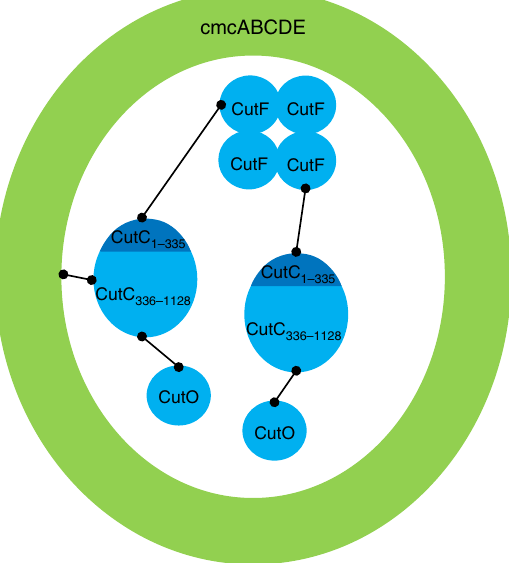
Fig. 3 Proposed enzymatic core encapsulation mechanism of CutC, CutF, and CutO in GRM2 BDPs. CutC is serving as an adaptor for the encapsulation of other enzymes. CutC C-terminal domain is responsible for encapsulation and also for interaction with CutO. The CutC N-terminal domain is responsible for CutC interaction with CutF. CutF together with CutC N-terminal domain crosslinks the enzymatic core and increases its